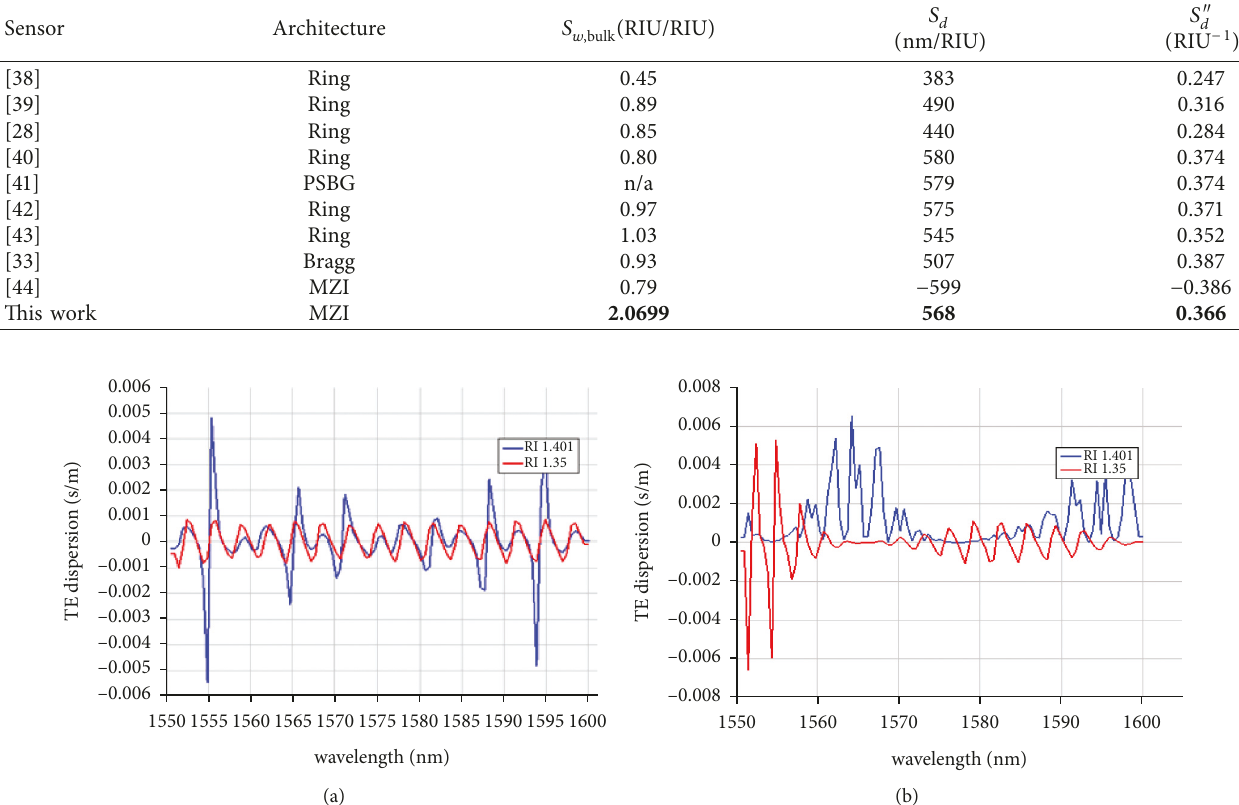
1550nm with other silicon-based photonic sensors. (cid:27)